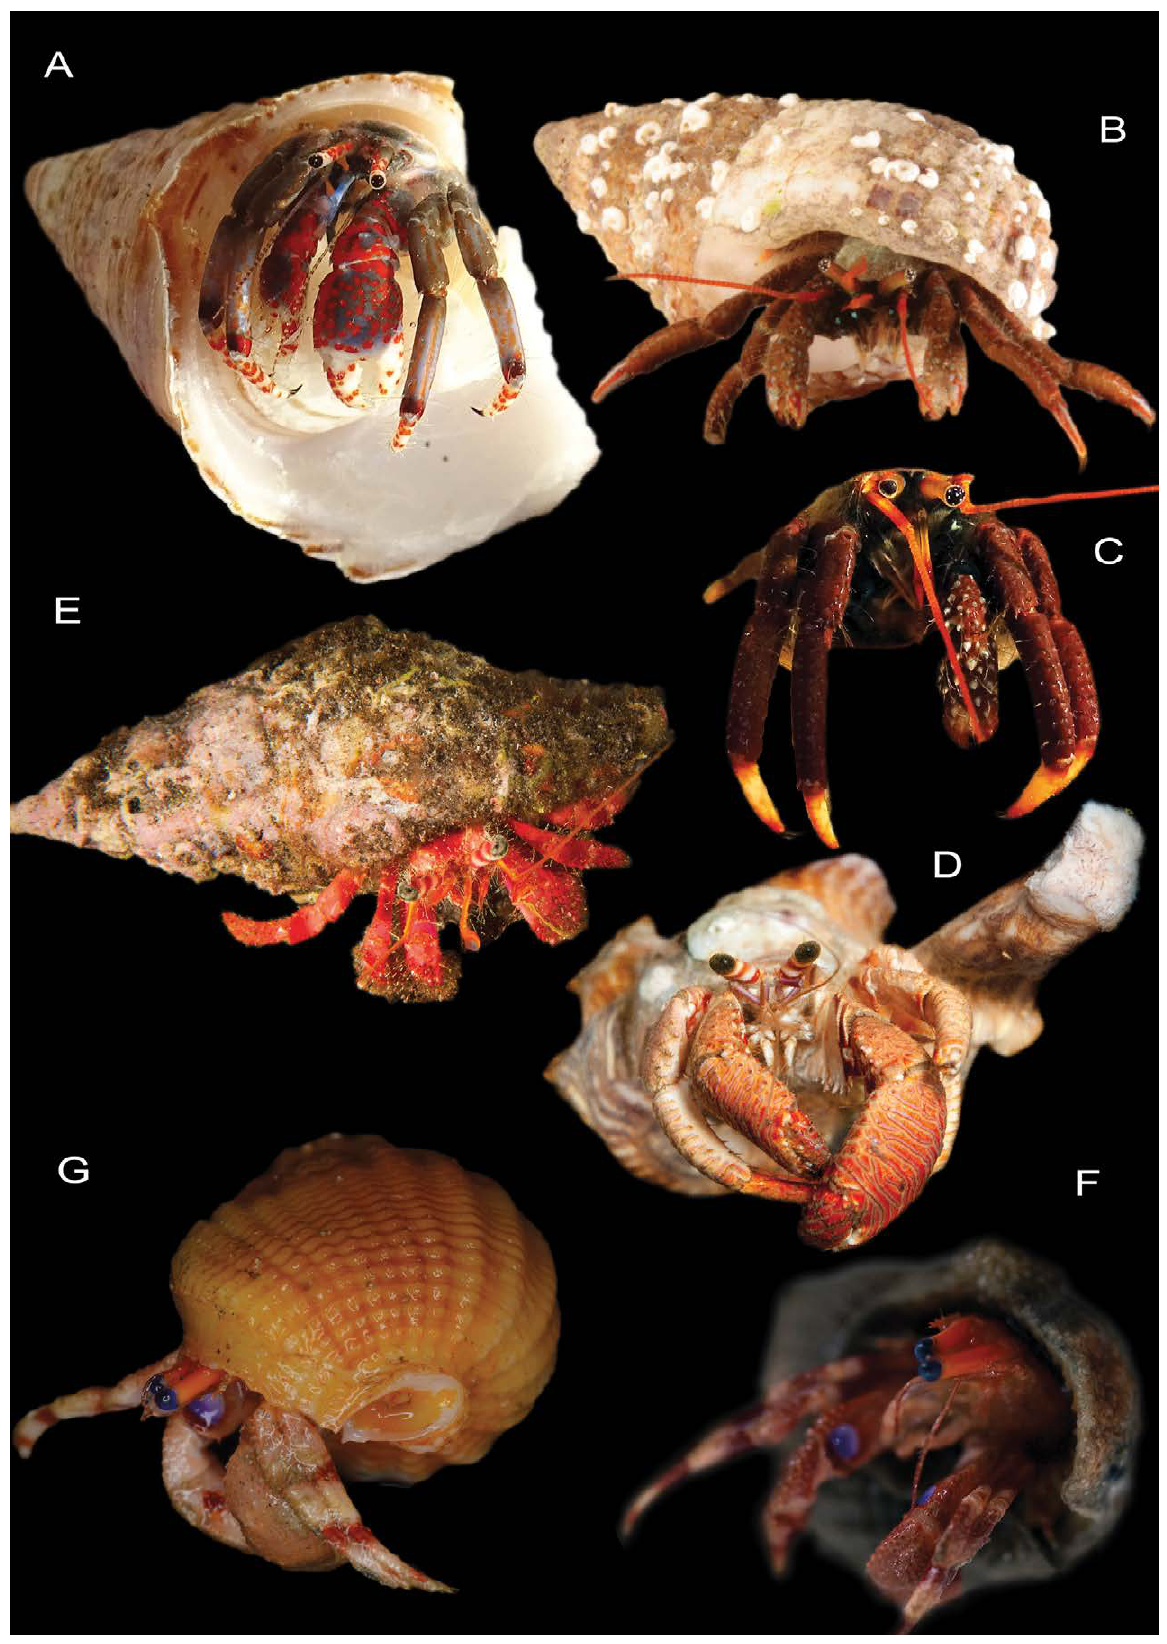
Fig. 16. – Colour photographs of species belonging to the family Diogenidae. A, Calcinus tubularis (IEOCD-BR/317); B, Clibanarius erythropus (IEOCD-BR/325); C, Clibanarius aequabilis (IEOCD-BR/326); D, Dardanus arrosor (IEOCD-BR/354); E, Dardanus calidus (IEOCD-BR/361); F, Paguristes eremita (IEOCD-BR/372); G, Paguristes rubropictus